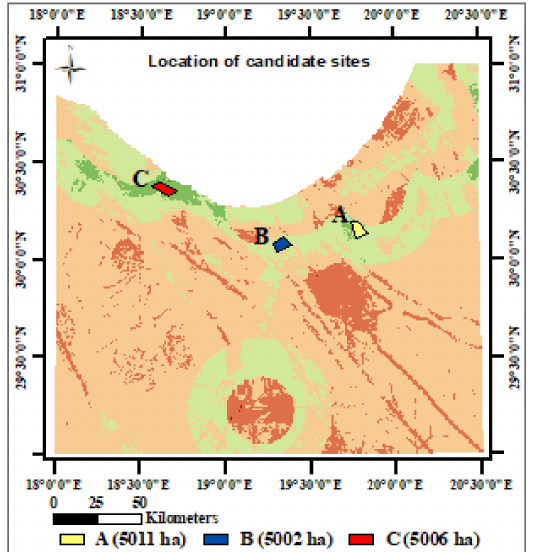
Figure 14. Location and area of candidate